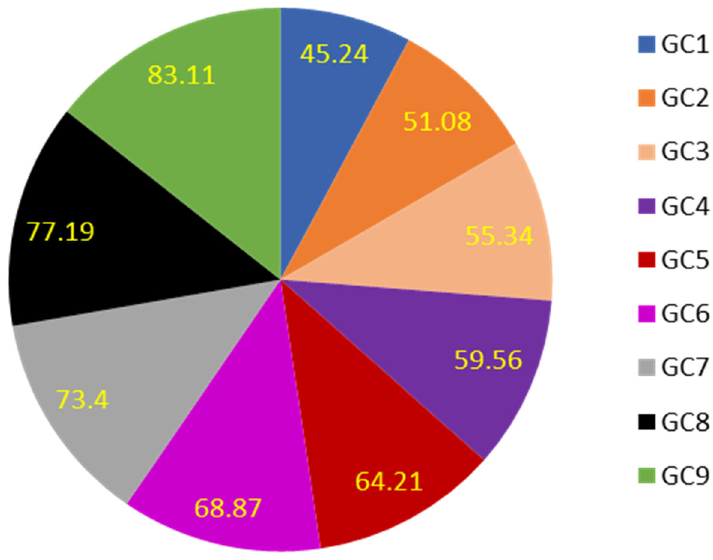
Figure 5. EE% of GFT-CNP formulae (GC1–GC9).